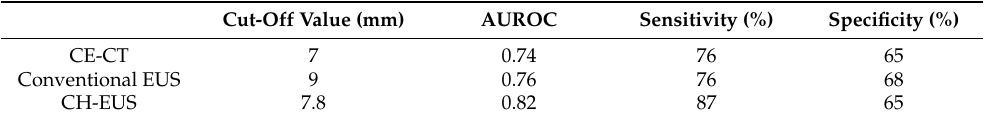
Table 5. Diagnostic Abilities for Invasive IPMC According to the Size of Mural Lesion on CE-CT, Conventional EUS, and CH-EUS.